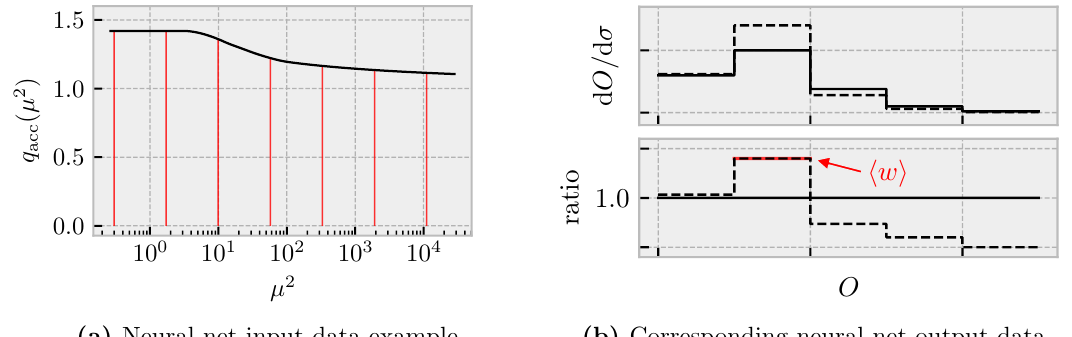
Figure 1 . Visualisations of the neural network input/output data for a given observable bin (here the second bin in the histogram for an observable O , depicted in the right-hand panel). Given a number of values of q acc for a variation (left-hand panel) as input, the NN is trained such that it outputs the corresponding value w for the given h i